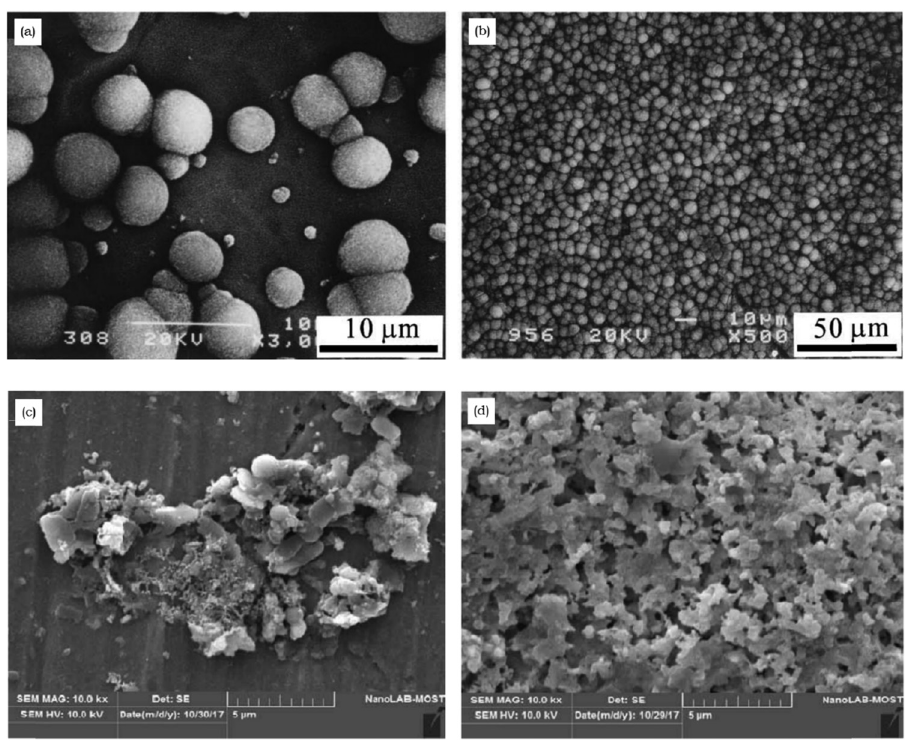
Figure 3: Scanning electron microscopy ( SEM ) images of hydroxyapatite deposited on the Ti surface ( a and b ) using HPT and ( c and d ) sol – gel techniques. The newly formed apatite layer depending on di ff erent conditions, pH, temperature, and time led to ( a and c ) initial and ( b and d ) complete stages of HAp formation. [ 35 ] Copyright 2002, Elsevier; [ 36 ] Copyright 2020, Medico - Legal